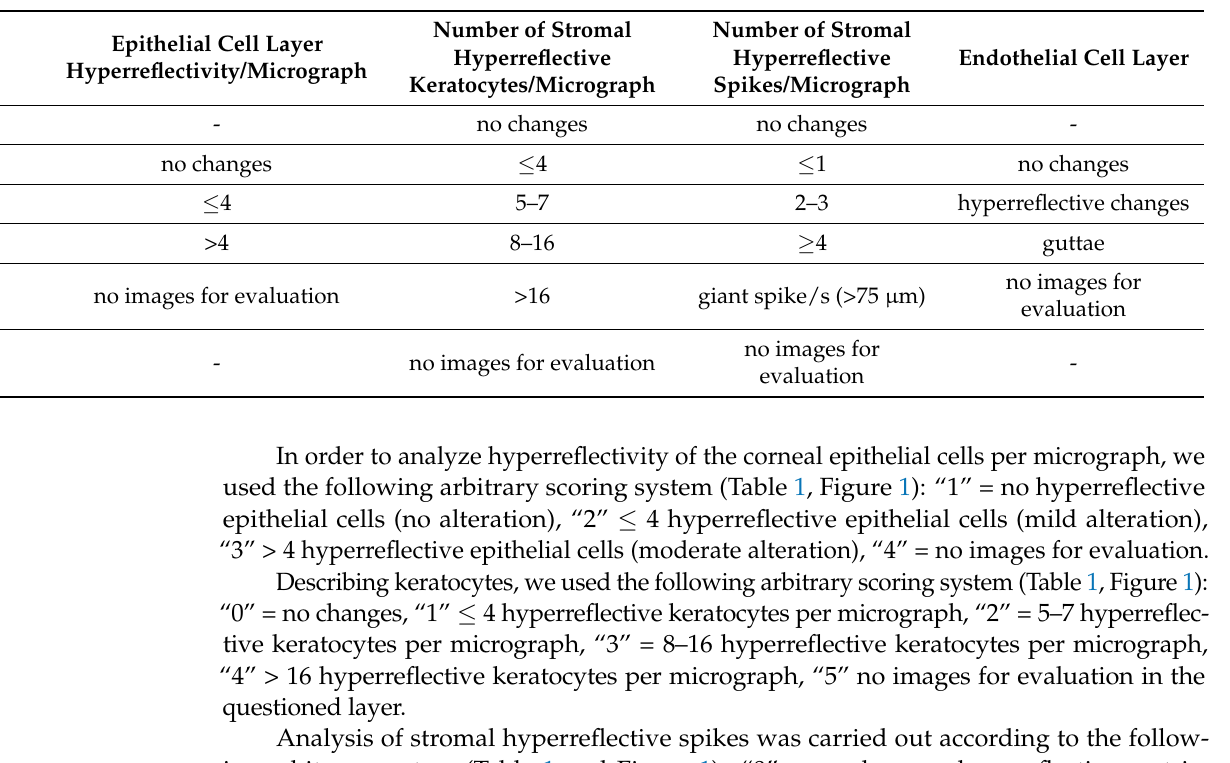
Table 1. Classification of epithelial cell layer properties, stromal hyperreflective keratocytes, stromal hyperreflective spikes and endothelial cell layer properties. We used a classification modified from Aragona et al.